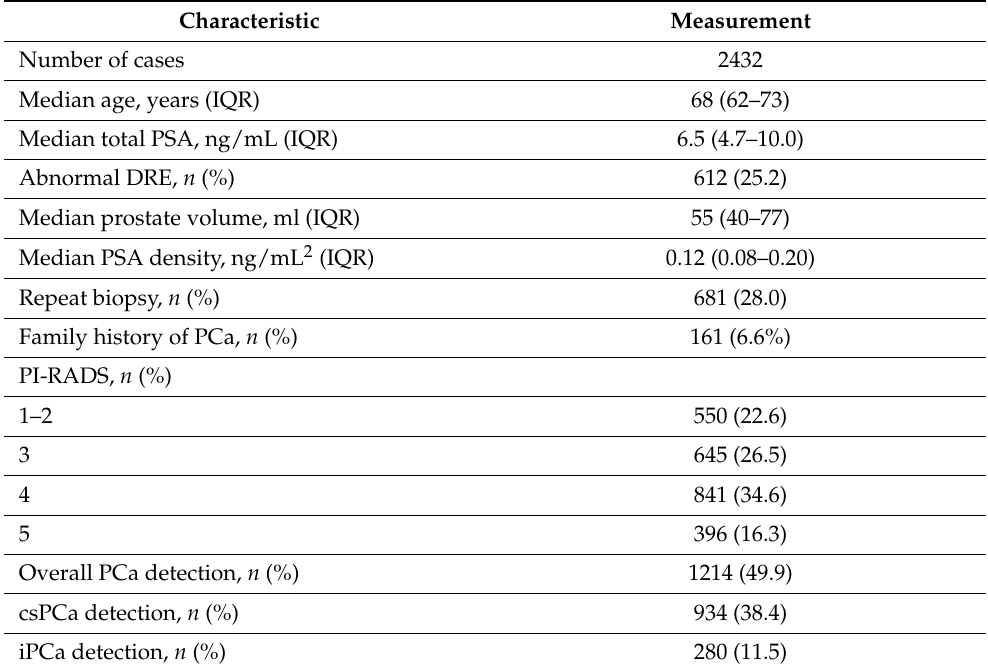
Table 1. Characteristics of study population.